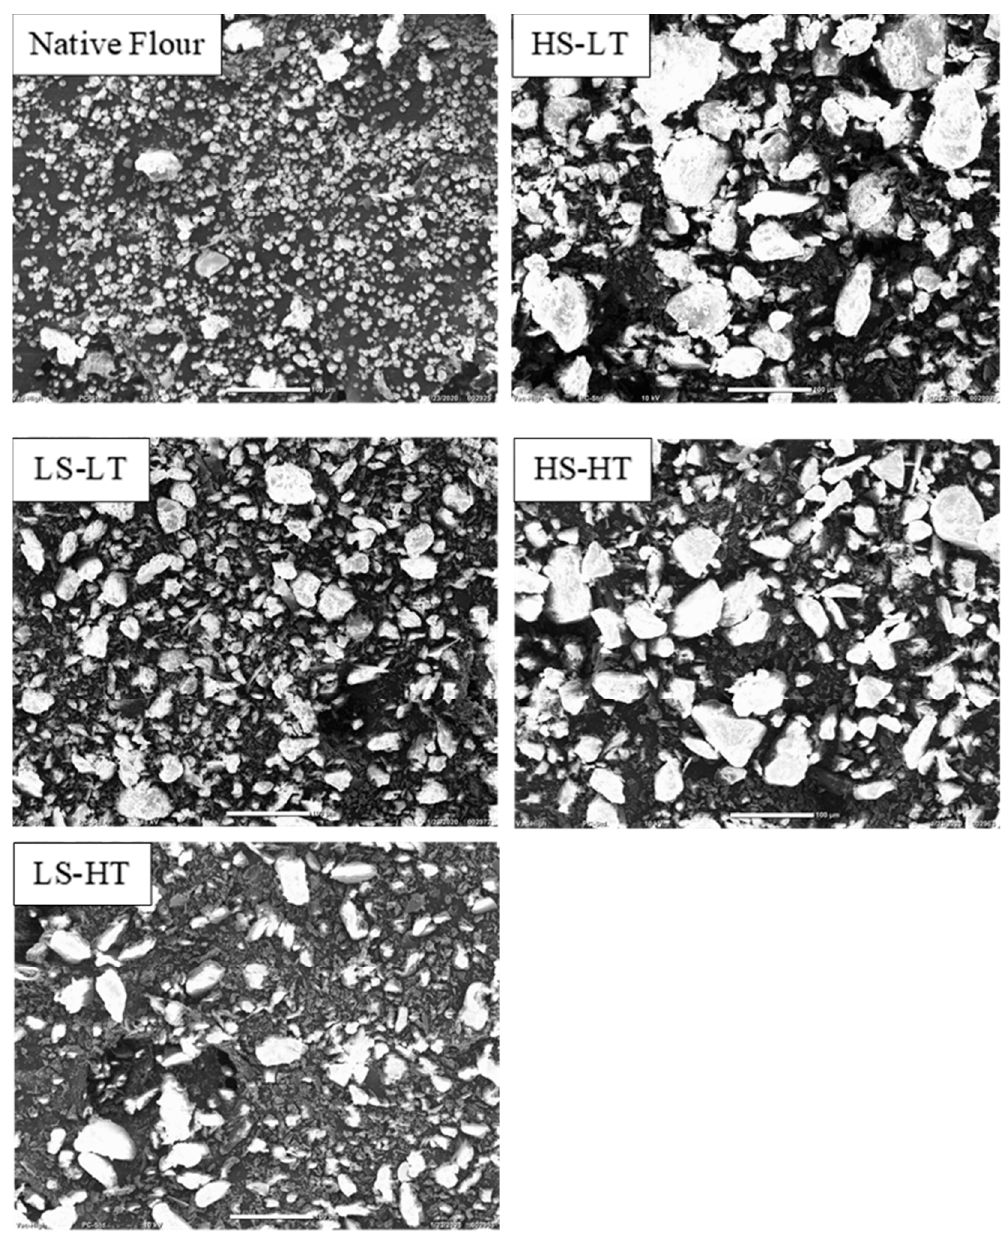
Figure 2. Micrograph images of native and extruded breadfruit flours on scanning electron microscopy. Treatments include native breadfruit flour and four extruded breadfruit flours: LS-LT: SME = 74 kJ / kg, melt temperature = 83 ◦ C; LS-HT: SME = 74 kJ / kg, melt temperature = 105 ◦ C; HS-LT: SME = 145 kJ / kg, melt temperature = 100 ◦ C; HS-HT: SME = 145 kJ / kg, melt temperature = 126 ◦ C.